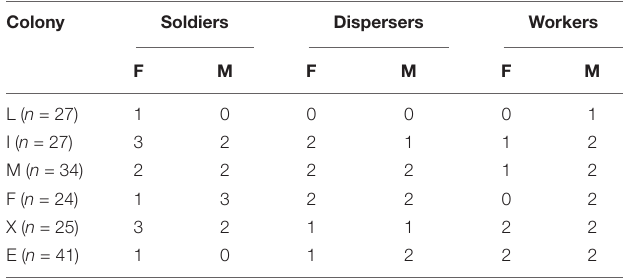
TABLE 1 | Summary of all individuals used for PPT. Colony Soldiers Dispersers